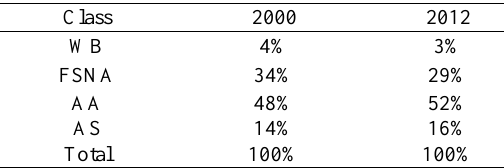
Table 2. Distribution of land use / cover classes